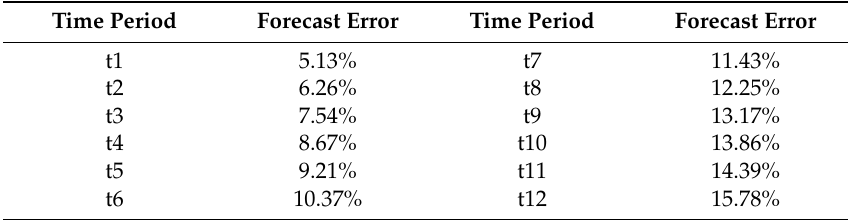
Figure 3. ( a ) Wind forecast curve; ( b ) Load forecast curve. Table 2. Wind Forecast Error.